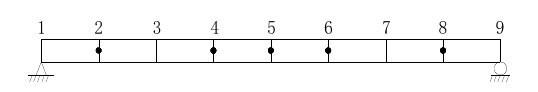
Fig. 6. Characteristic nodes of mode shape for fuzzy system